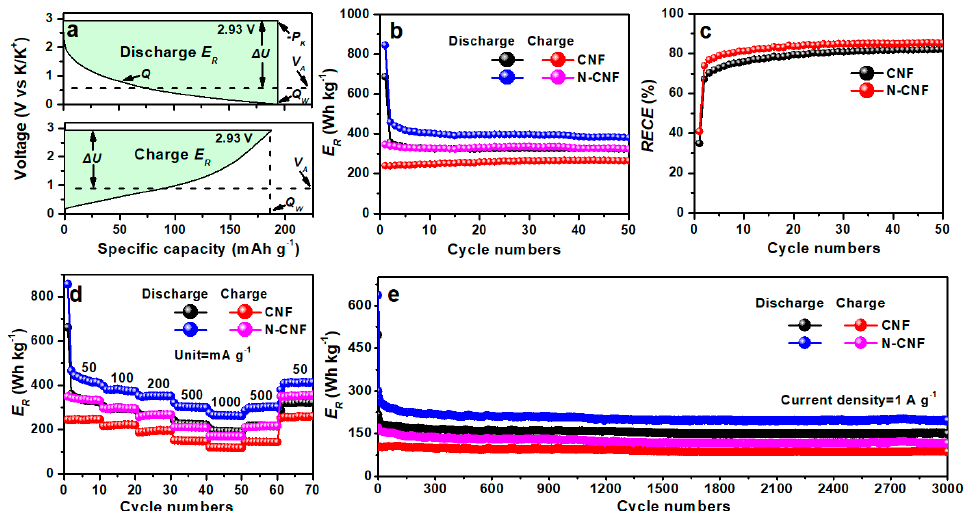
Figure 7. ( a ) Typical legends for the determination of the relative energy density ( E R ); ( b ) E R of CNF and N-CNF electrodes at the charge and discharge process, ( c ) relative energy conversion efficiency ( RECE ) of CNF and N-CNF electrodes, ( d ) rate E R performance and ( e ) long-term E R cycling performance of CNF and N-CNF electrodes.